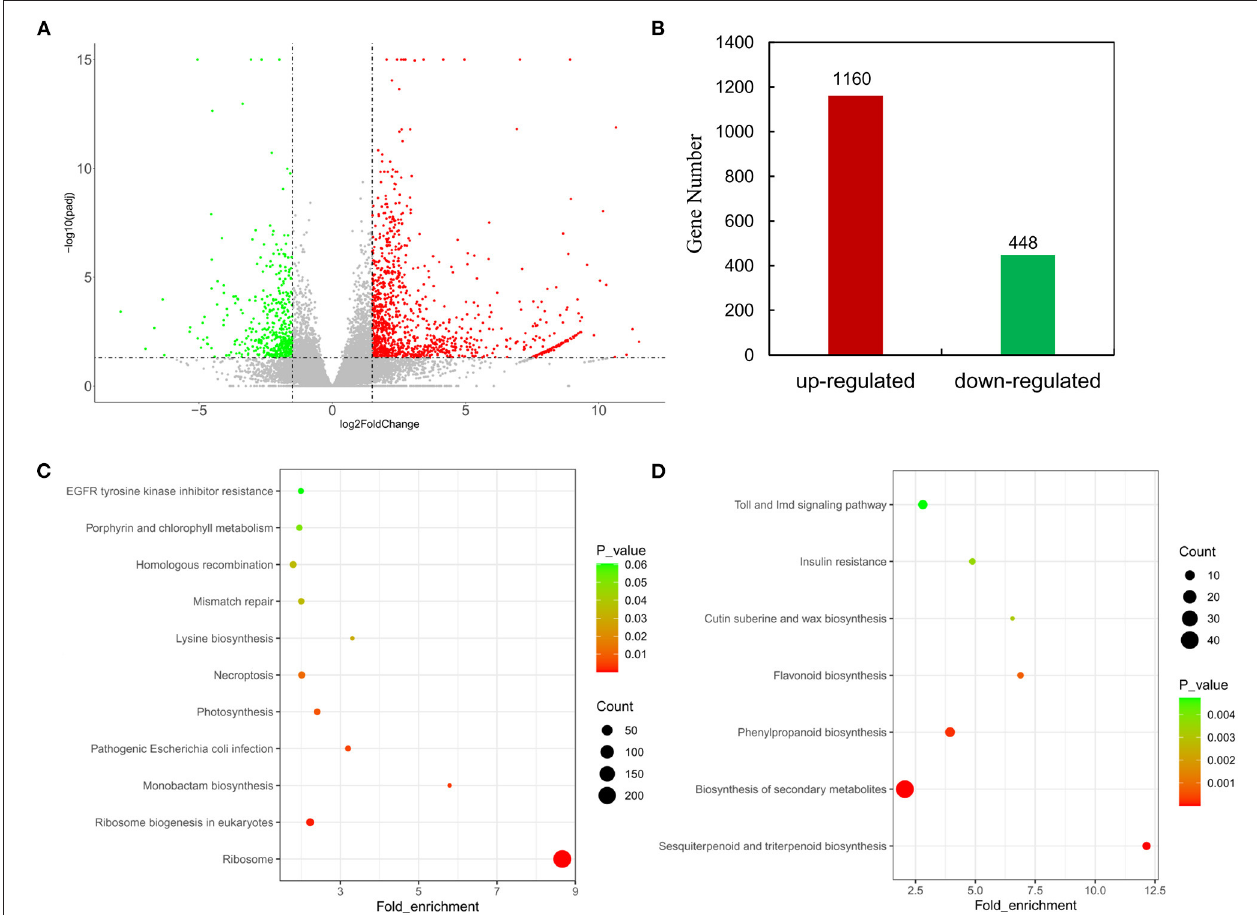
FIGURE 2 | Analyses on DEGs in leaves of two O. viciifolia samples. (A) Volcano plots of DEGs. The horizontal axis represents the values of Log 2 FoldChange of DEGs in the samples of high PAs and low PAs groups, and the vertical axis represents the statistical significance of differences with p -value. Red represents upregulated DEGs and green represents downregulated DEGs. (B) Gene number of upregulated DEGs and downregulated DEGs. (C) Enrichment analyses of KEGG function of upregulated DEGs with 1,160 genes. (D) Enrichment analyses of KEGG function of downregulated DEGs with 448 genes. The horizontal axis is the fold enrichment factor, and the vertical axis is the KEGG pathway. The bubbles represent the number of genes. Different colors represent significance of differences ( p